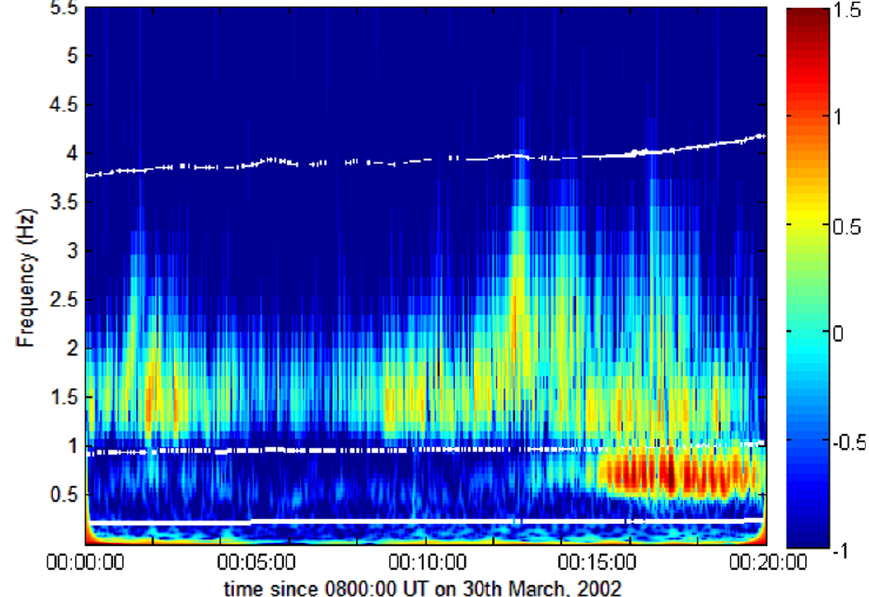
Fig. 2. Frequency–time wavelet spectrogram of ULF waves observed on 30 March 2002, on Cluster 1 ( B y component of magnetic field) from FGM. The colour bar is in arbitrary units representative of relative power spectral density. An area of reduced wave energy can be seen around 1Hz at the local (cid:127) corresponding to a stop band. The white lines, from top to bottom, represent (cid:127) H + , (cid:127) He + respectively.